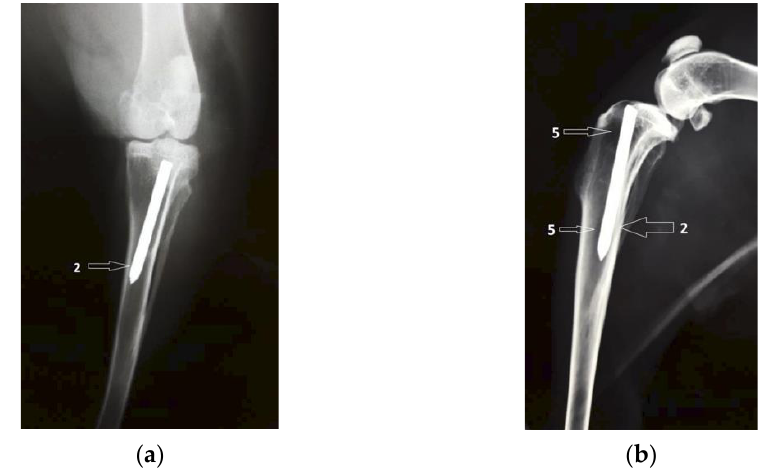
Figure 5. Group one, Mg – 1Ca intramedullary pins, 6 weeks after surgery. 1-Mg-1Ca alloy pin with partial resorbtion, 2-Pneumoarthrosis indicated by intra-articular gas bubbles, 3-Fibrous tissue for- mation formed at the bone-implant interface. ( a ) Coronal view; ( b ) Lateral view.